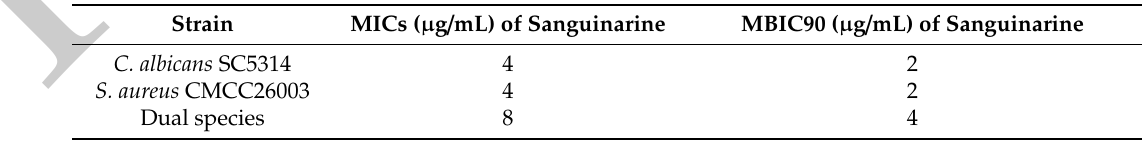
Table 1. MICs and MBIC90 of sanguinarine against mono- and dual-species of C. albicans SC5314 and S. aureus